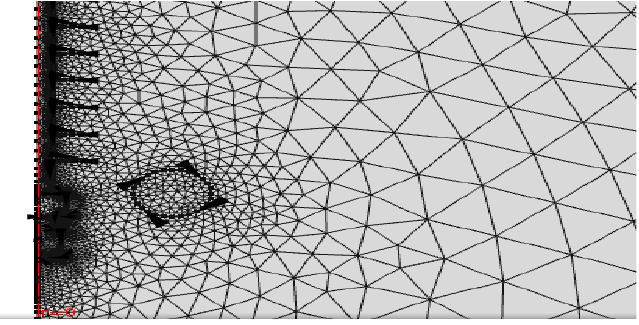
Figure 3. Meshing elements in 2D model .